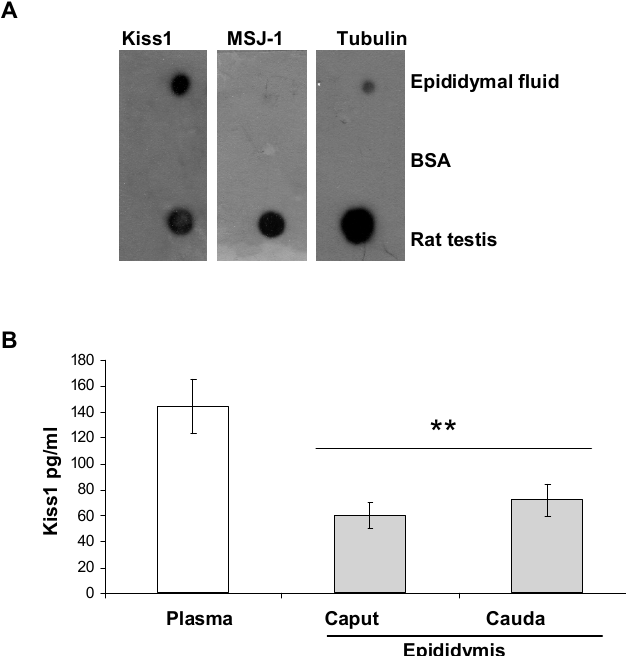
Figure 7. Kiss1 presence in the epididymal fluid. ( A ) Dot blot for Kiss1, MSJ-1, and α -tubulin carried out on epididymal fluid (10 µ g proteins), Bovine Serum Albumine (BSA, negative control, 10 µ g), and rat testis (positive control, 10 µ g proteins). ( B ) Elisa assay for the measure of Kiss1 in plasma (positive control) and epididymal fluid collected from the epididymis caput and cauda of 8–10 weeks old rats ( n = 4). Asterisks indicate statistically significant differences vs. plasma ( p < 0.01).